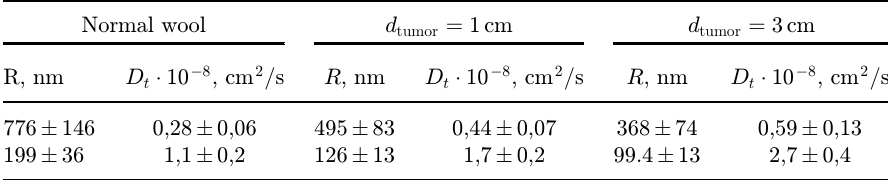
Table 1. Cells radius of external wool layer and their di®usion coe±cients. Normal